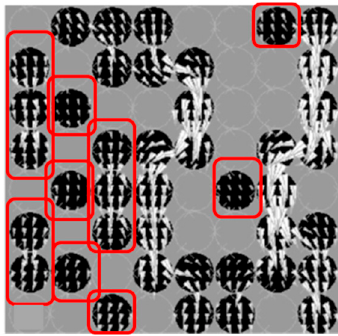
Figure 4. Illustration of an internal demagnetizing mechanism. (Dark spheres represent magnetic particles, the non-magnetic phase is colored in grey). (Figure adapted from [16]).